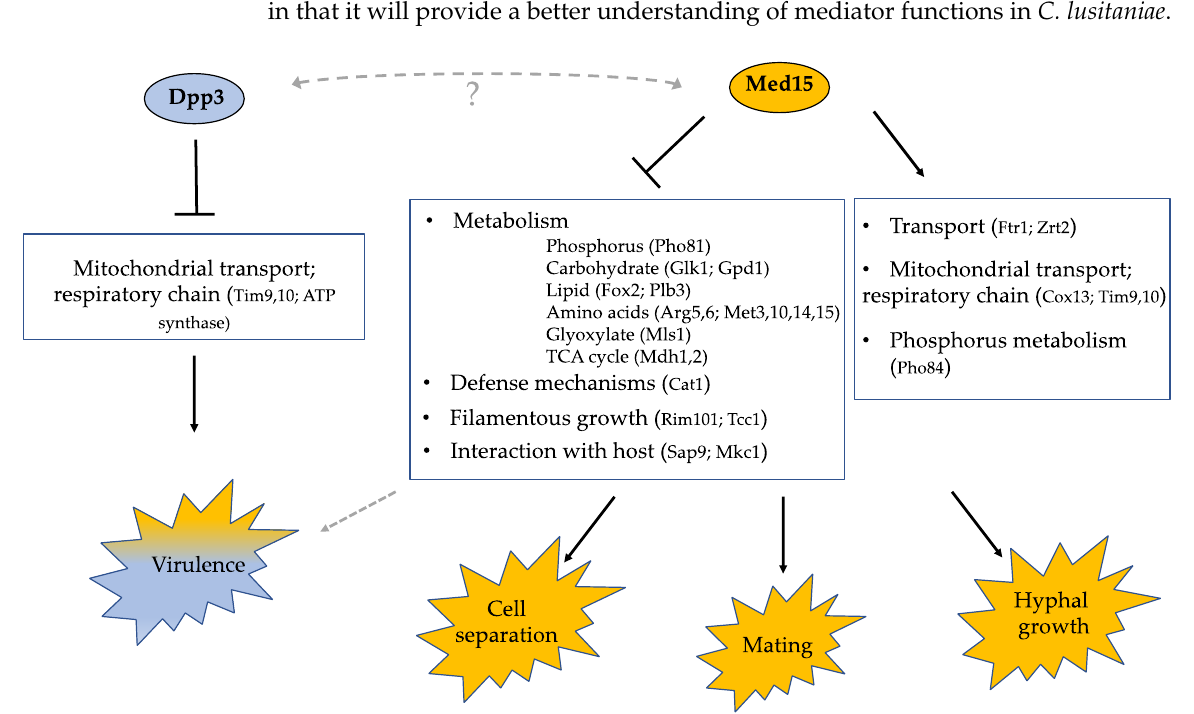
Figure 8. Summary of the functions of Med15 and Dpp3 in C. lusitaniae and of the biological pathways involved. Med15 is a subunit of the tail module of the mediator complex. Based on sequence homology with its orthologs in S. cerevisiae and C. albicans , Dpp3 is predicted to be a putative phosphatase in C. lusitaniae . The inactivation of DPP3 repeatedly drove an additional mutation in MED15. Dpp3 was shown to play an important role in virulence [25]. In this study, we show that Med15 controls diverse cellular processes, such as cell separation, mating and hyphal growth. The role of Med15 in virulence was inferred from the partial restoration of virulence in the reconstituted strain dpp3 ∆ + DPP3 but was not formally demonstrated. Proteomic analyses allowed to uncover the biological processes under the positive or negative regulation of Med15 and Dpp3. Dotted lines and question mark indicate that the links remain to be demonstrated.